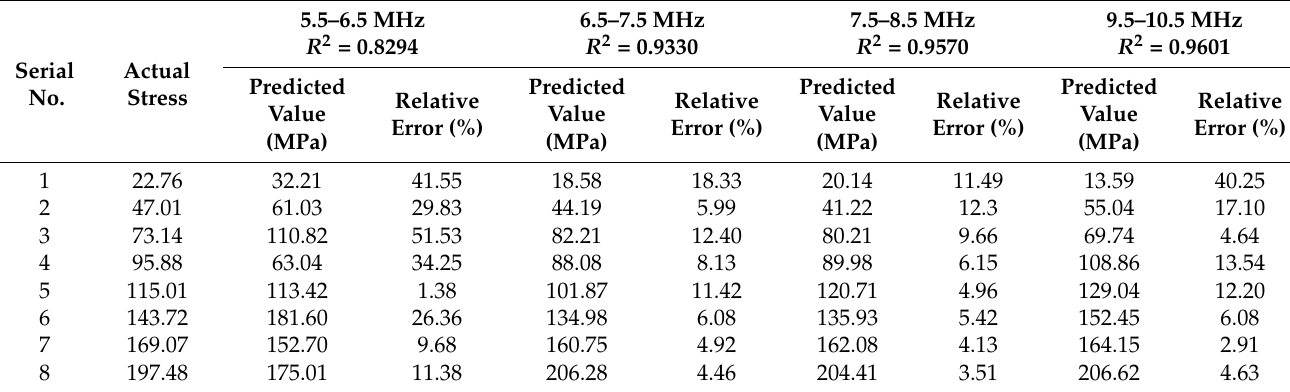
Table 5. Prediction results in the other four